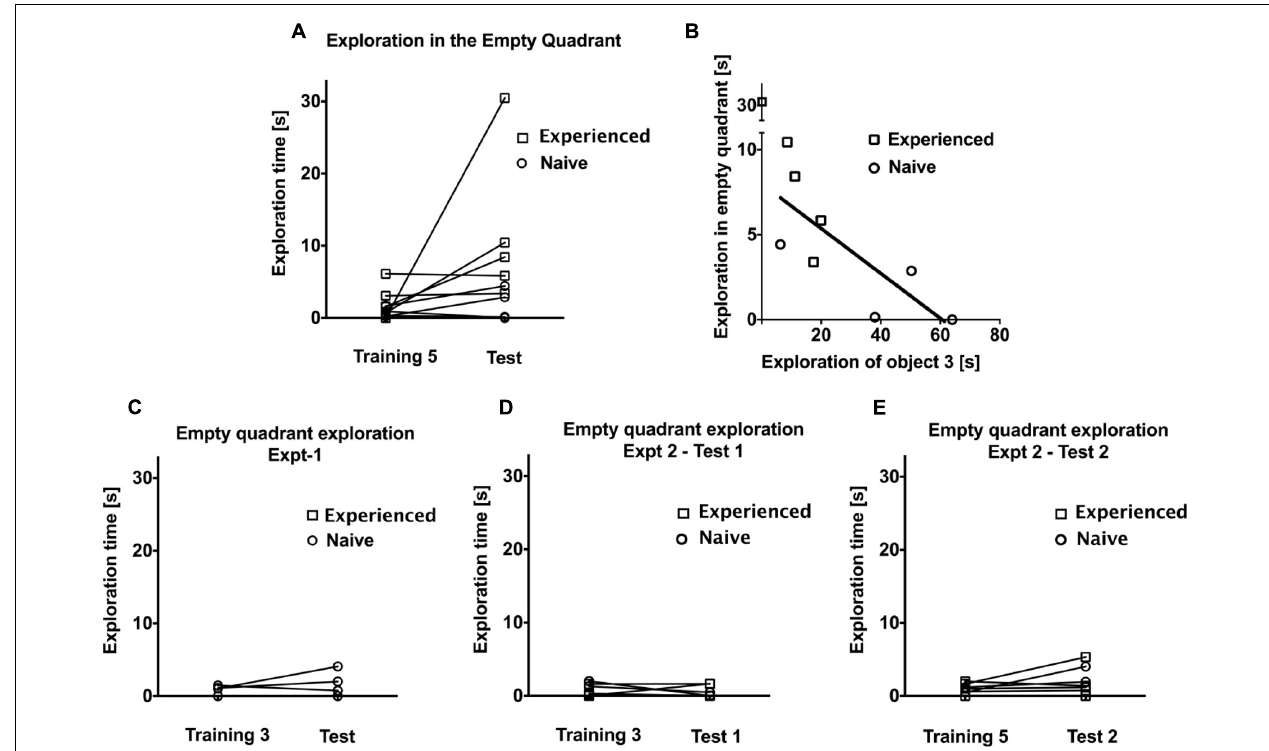
devote little exploration to the displaced object on the test day in Experiment 3. C–E shows the comparison of exploratory activity of the empty quadrant during the test session and the corresponding area on the prior training session in Experiment 1, Experiment 2 for test 1 and prior training session, and test 2 and prior training session, respectively, for experienced and naive